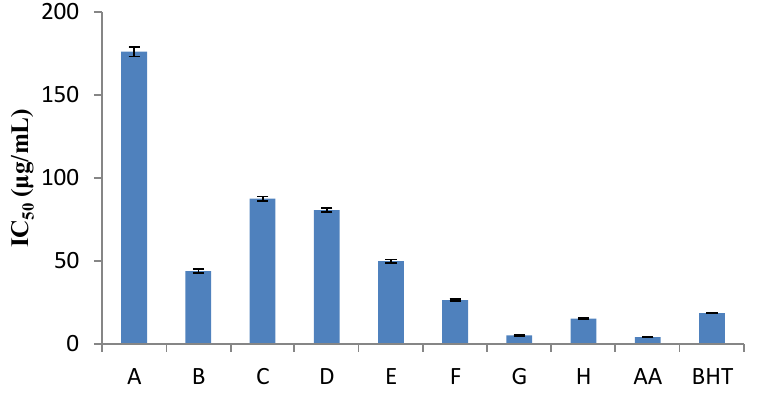
Figure 2. Free radical scavenging activities of some essential oils.